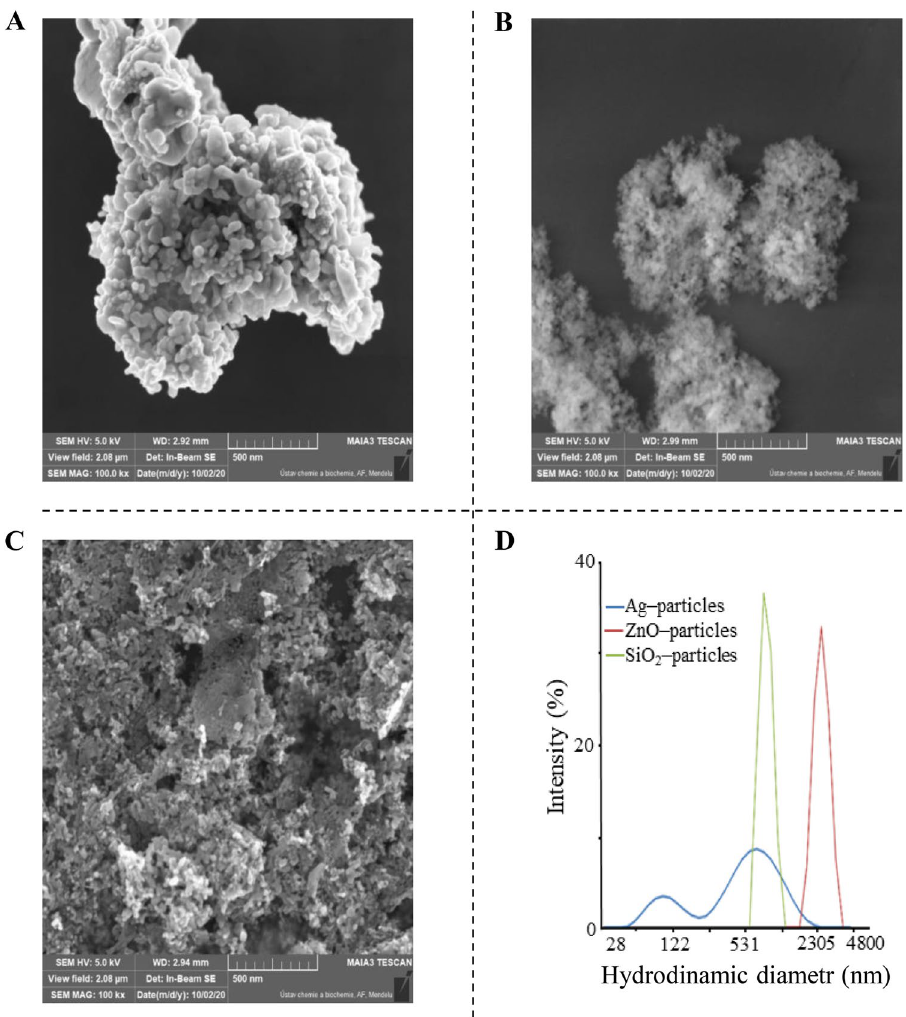
Figure 1. SEM images of (A) Ag NPs, (B) SiO 2 MPs, and (C) ZnO MPs. (D) DLS particle size distribution profiles of nanoparticles in aqueous